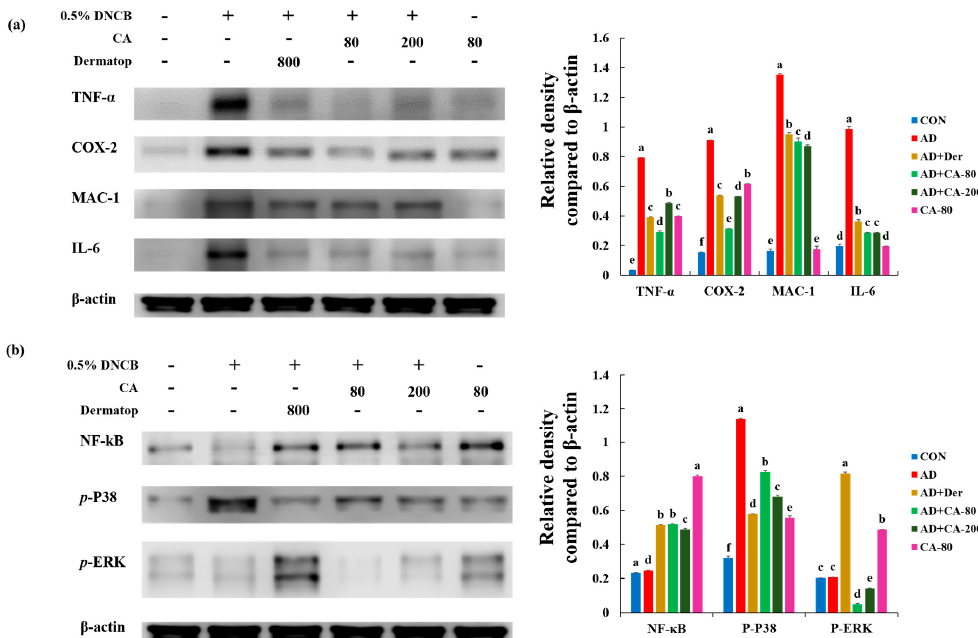
Figure 9. Alleviation of increased expression of ( a ) various pathogenic cytokines and ( b ) NF- κ B and mitogen-activated protein kinase (MAPK) proteins in AD-induced mice model, following treatment with CA-80 and CA-200. Values represent the mean ± SD. Values with di ff erent letters were significantly di ff erent according to Duncan’s multiple range test ( p <